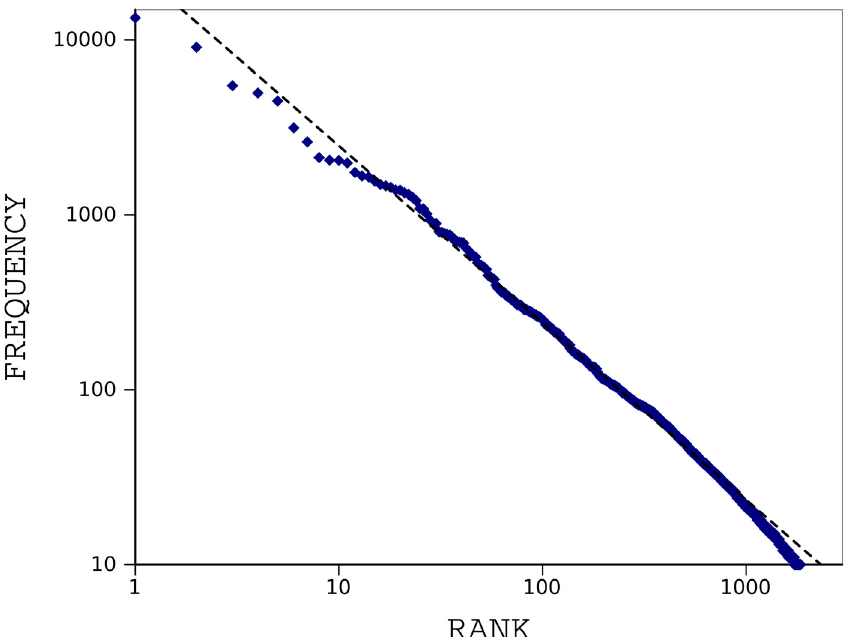
Fig 1. Zipf ’ s law for the book The Origin of Species . Frequency of each word is inversely proportional to its rank in form of power law. The Zipf curve follows a straight line with a slope of − 1.01 when plotted on a double-logarithmic